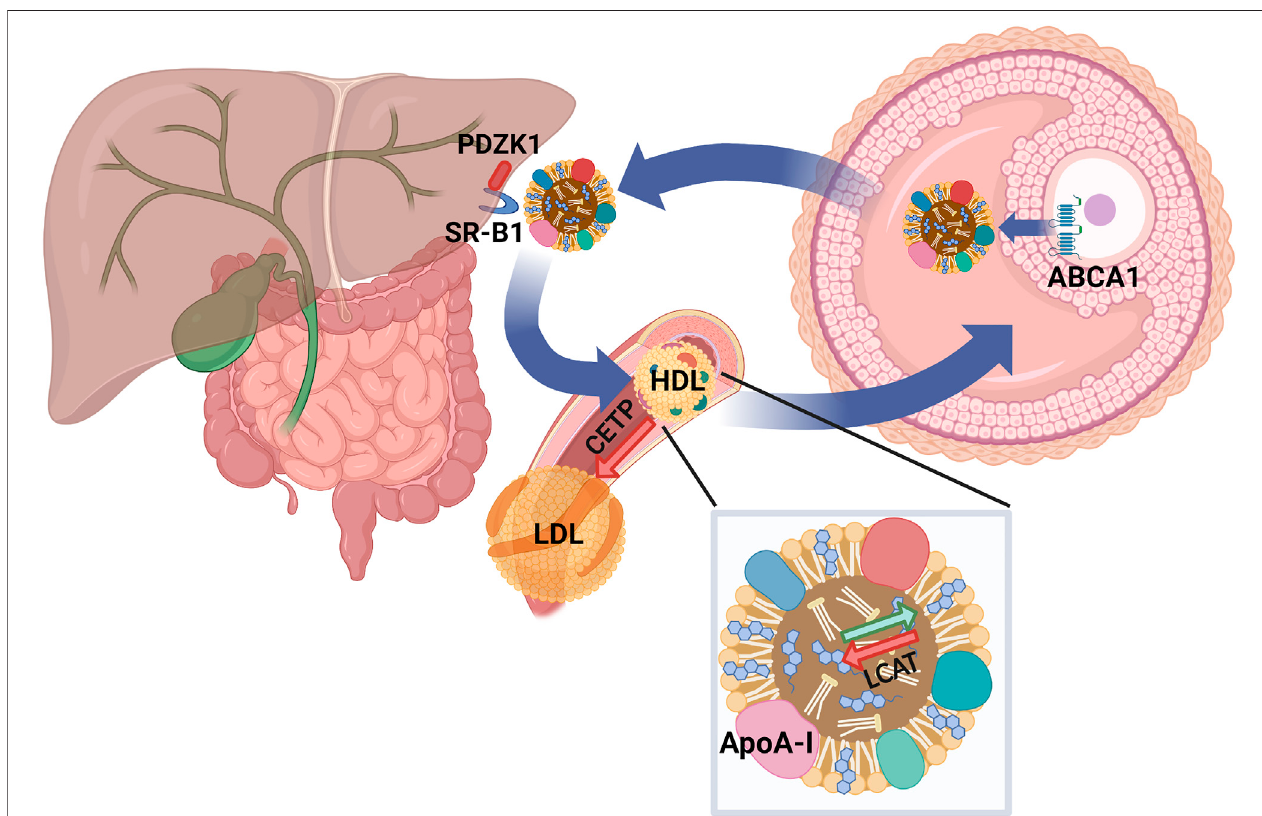
FIGURE1| Workingmodel.WeproposeahomeostaticmechanismintheovaryinwhichFFHDLensureadequatecholesterollevelsintheeggbyremovingexcess cholesterolfromtheoocyteduringtheantralstageoffolliculardevelopment.SR-B1:ScavengerReceptorClassBType1;ABCA1:ATP-BindingCassettetransporterA1; CETP: Cholesteryl Esther Transfer Protein; LCAT: Lecithin Cholesterol Acyl Transferase; PDZK1: PDZ domain containing 1. Created with BioRender.com.